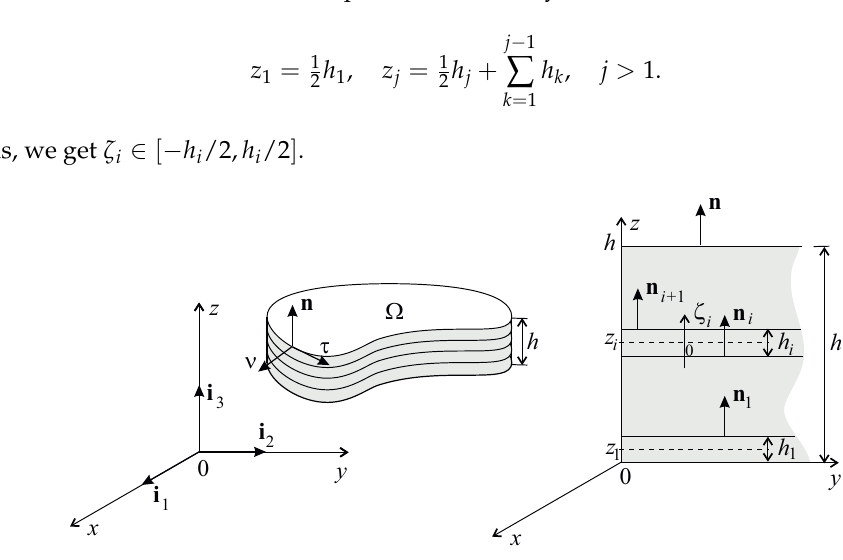
Figure 1. N th layered plate of thickness h . Here N = 4, and the i th layer has a thickness of h i , i = 1, . . . ..., N